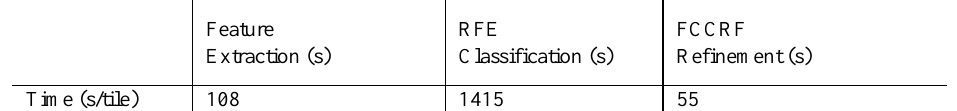
Table 2. Time costs at different stages of the proposed classification pipeline for a tile with 2000x2500